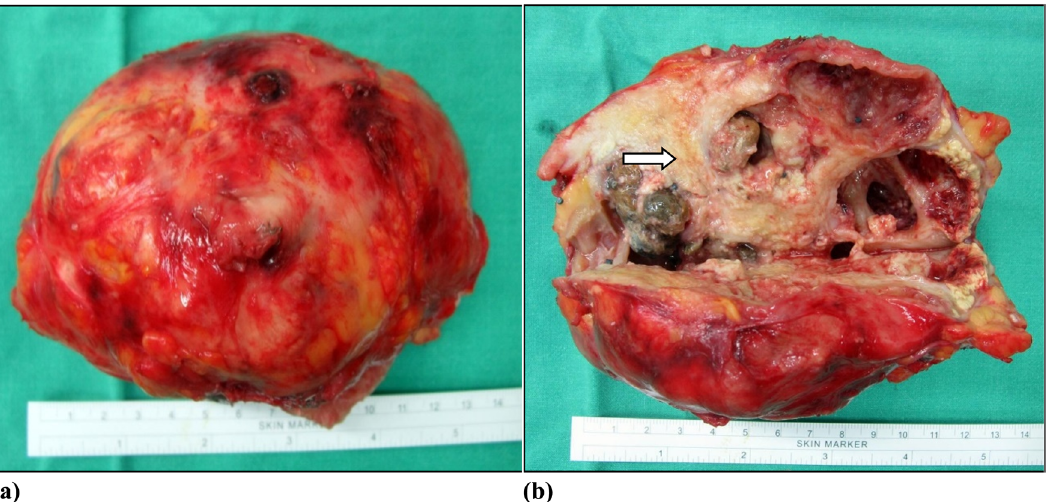
Figure 2: Specimen photographs. ( a ) Gross appearance of the specimen reveals a thickened kidney capsulate with adherence to the cortex and the peri - renal fat, measuring 11.2 × 7.6 × 6.6 cm. ( b ) The cut section of the kidney shows a dilated pelvis and calyces with thinning of the renal parenchyma. There are stones within the calyces and the pelvis is obstructed by a staghorn stone ( arrow ) .